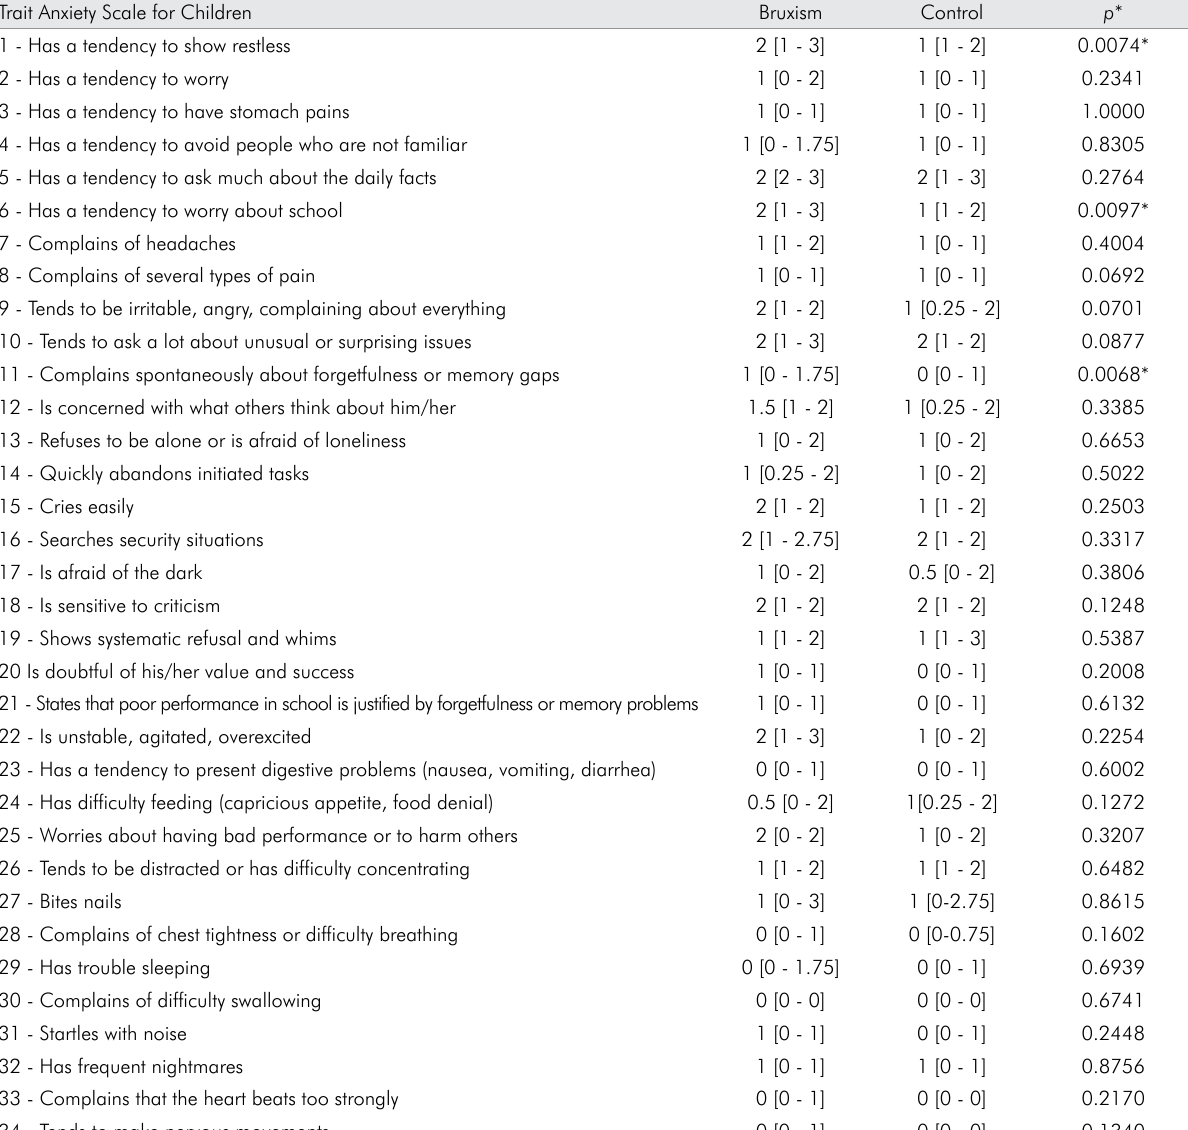
Table 2. Median (1 st and 3 rd quartiles) of responses (levels) to questions of trait anxiety scale for children for each study group. Trait Anxiety Scale for